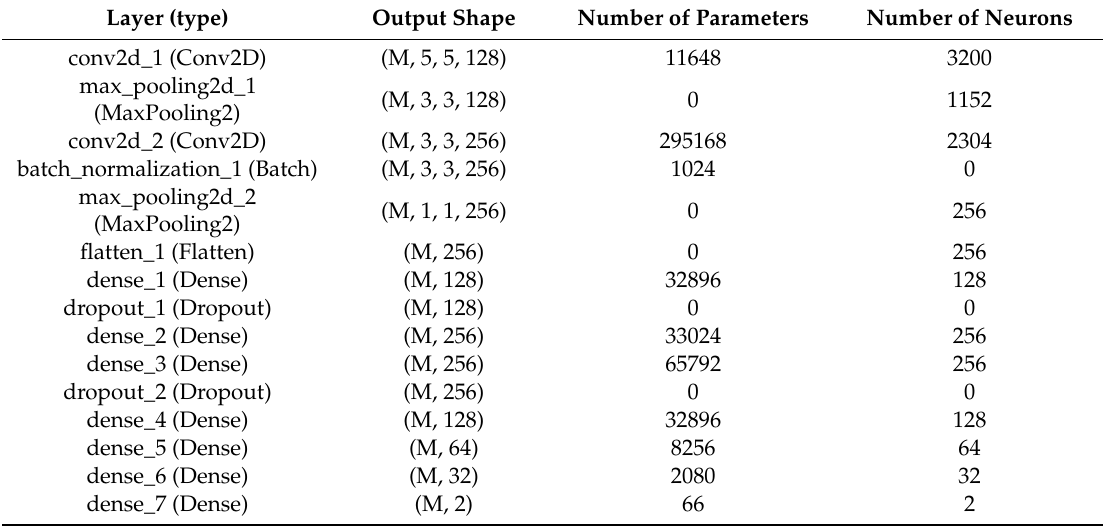
Table A1. The detailed information of CNN model with the size of 5 ×